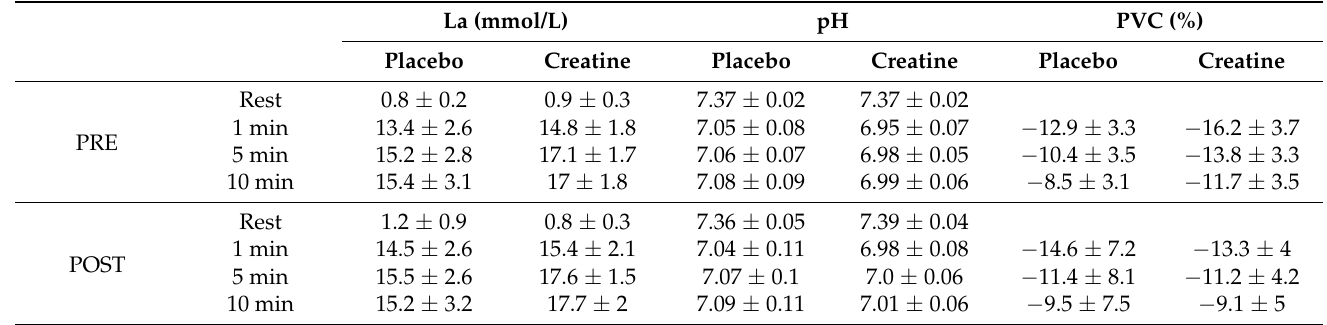
Table 2. Blood metabolites and plasma volume changes (PVC) pre- and post-supplementation in each group at rest and following 1, 5, and 10 min of recovery.